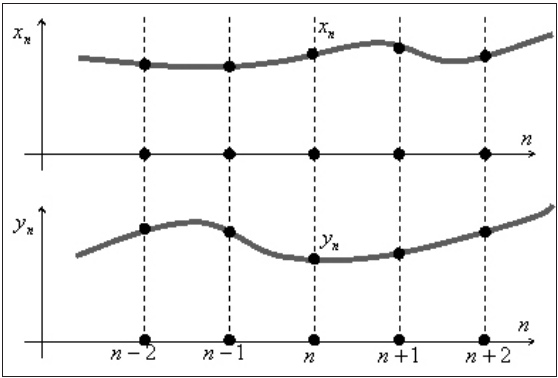
Figure 1. The scheme of time